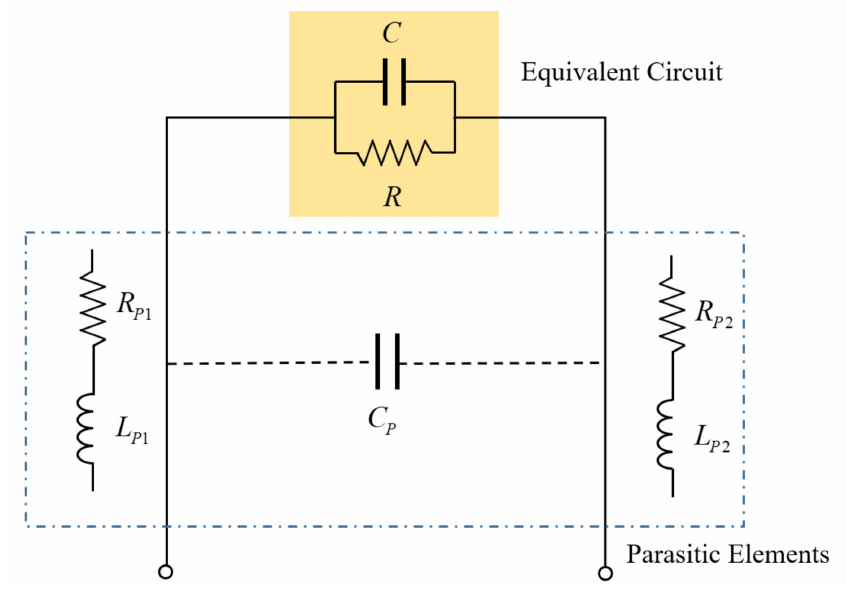
Figure 5. Parallel RC circuit with parasitic